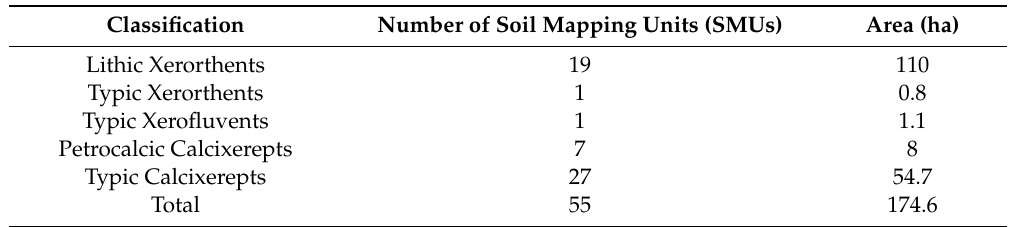
Table1. GroupingofsoilsaccordingtotheUnitedStatesDepartmentofAgriculture(USDA)taxonomical system to the level of